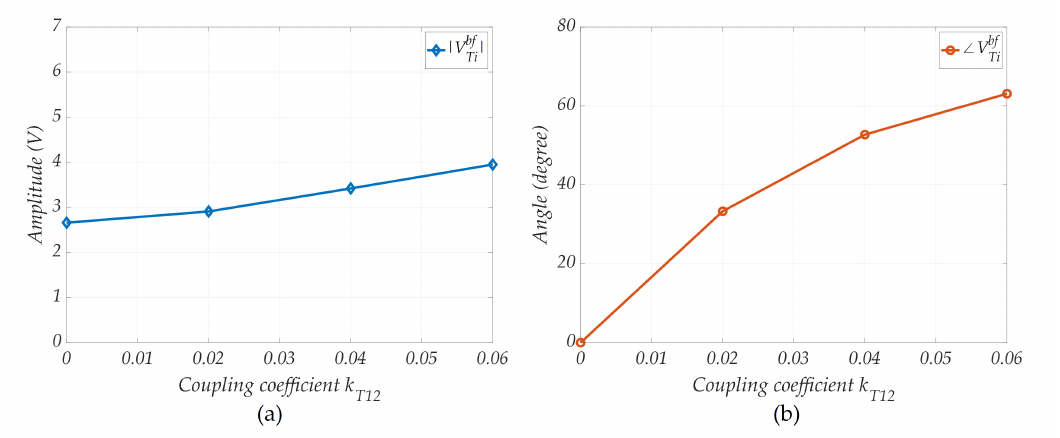
# » V bf when S in is fixed at 5 VA: ( a ) | V bf T